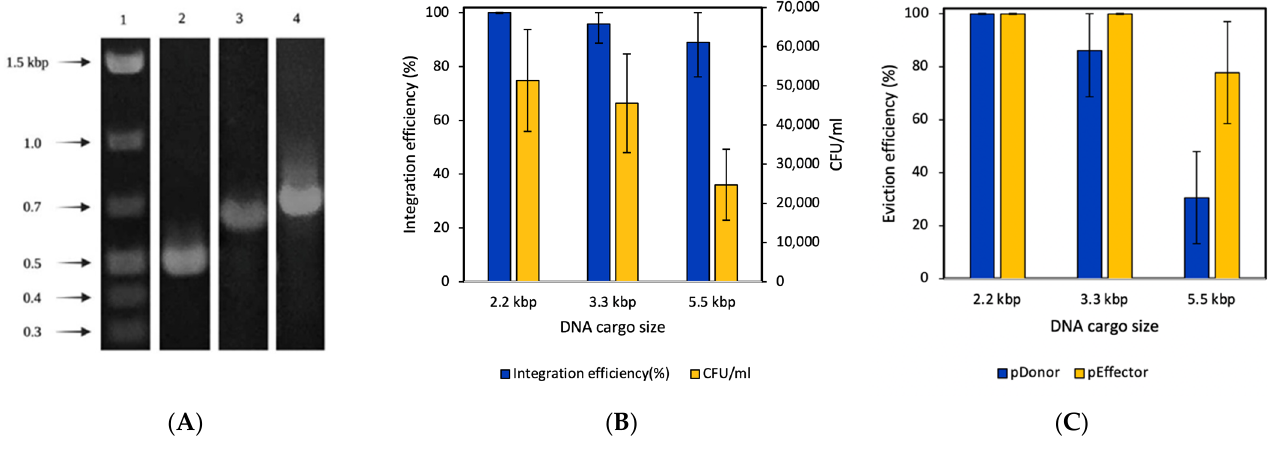
Figure 4. ( A ) Colony PCR screening of cas9 , bktB : phaB and phaC : phaA integrations via Tn6677 transposons (column 2–4). To screen for cas9 integration, primers P070/P073 amplified a 484 bp fragment (column 2). To screen for bktB : phaB integration, primers P072/P074 amplified a 641 bp fragment (column 3). To screen for phaC : phaA integration, primers P075/P076 amplified a 704 bp fragment (column 4). ( B ) Integration efficiency (ratio of colonies containing the desired mutation to the total number of colonies screened for colony PCR) and colony count (CFU/mL) of each transformation employing transposon-associated CRISPR-Cas system to integrate small-, medium- and large-size DNA cargos. ( C ) pDonor and pEffector plasmid eviction efficiencies (ratio of colonies with successful plasmid eviction to total number of colonies screened for antibiotic sensitivity). All values are reported as means ± SD ( n = 3).